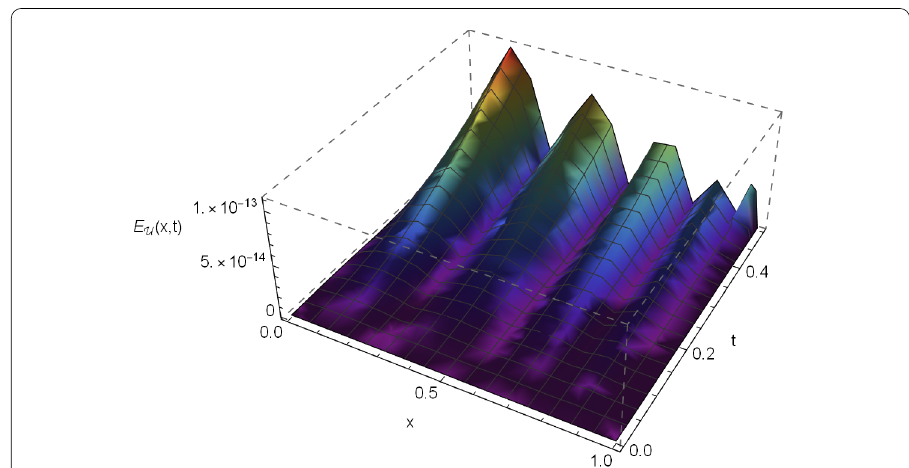
Figure 6 E U of problem (3), with δ = 1.8, N = 10, M = 2